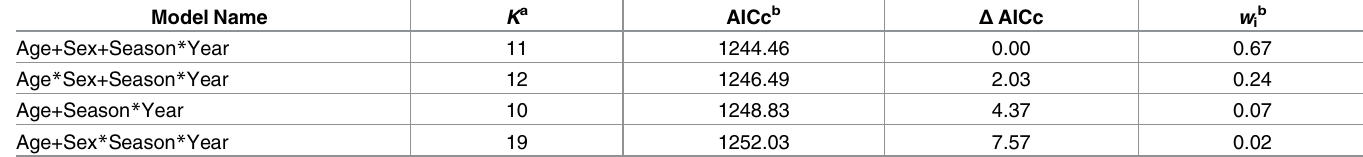
Table 3. Logistic regression models predicting variation in influenza A virus seroprevalence for mallards sampled in Fairbanks and Anchorage, Alaska from August through April of 2012–2015. Model Name